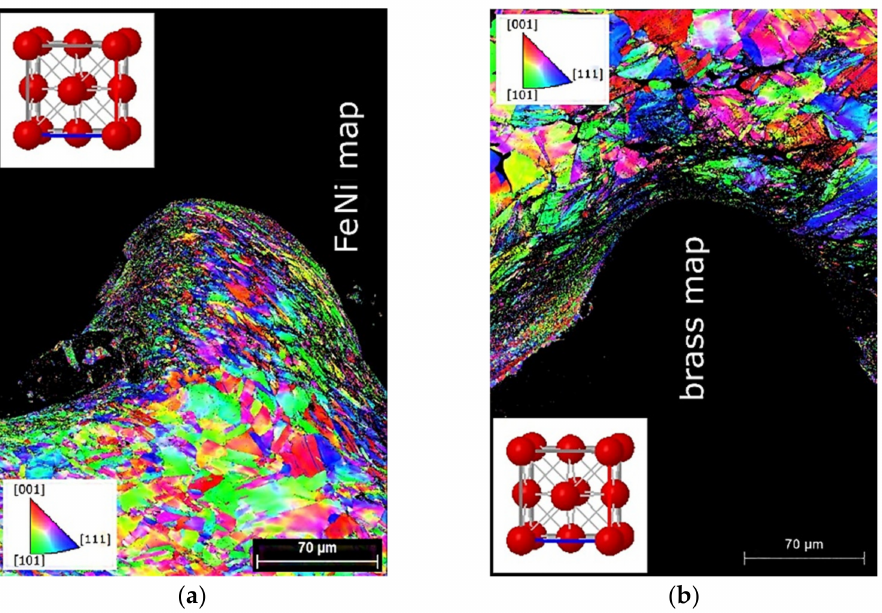
Figure 6. IPF-X maps of the grain structure near the weld interface: ( a ) Invar; ( b ) brass. The reference X-axis is directed vertically upwards. The color coding of the orientation is given by STT.